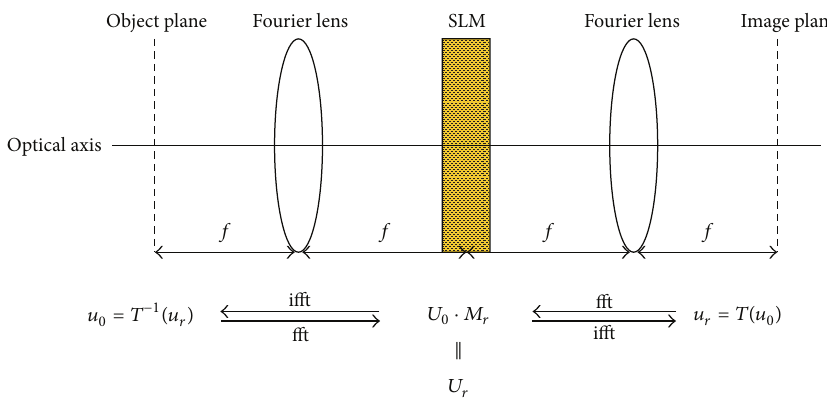
Figure 3: The 4f optical measure setup and brief GS based computational